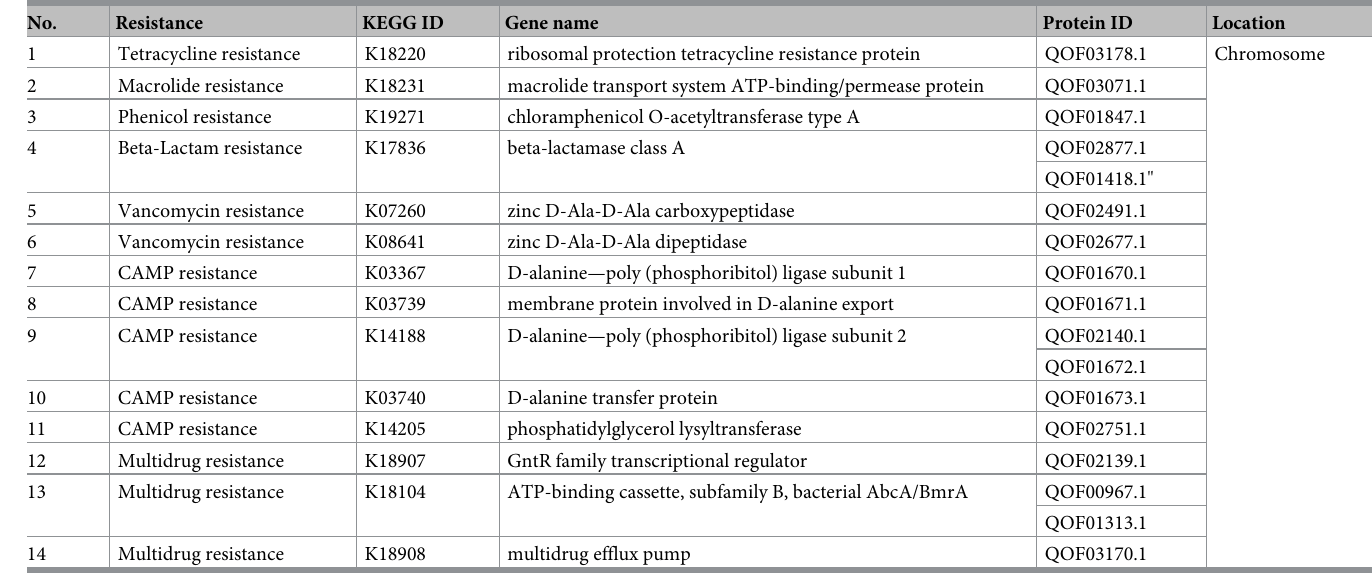
analysis, six phage regions were detected: three in the chromosome, two in plasmid 1, and one in plasmid 2 (Table 5). In addition, in mobile element analysis, nine regions were determined: five ISP2, one ISP1, and three ISLhe30, and all of them were insertion sequence (Table 6). However, antibiotic resistance genes were not present in these phage regions or mobile ele- ment sequence indicating a low possibility of transfer to other bacteria. Intrinsic antibiotic resistance is chromosomally encoded and not transferable to other bac- teria [47]. In case of vancomycin, the resistance or sensitivity is from intrinsic nature of bacte- ria such as Enterococcus , Lactobacillus , and Bifidobacterium ; their peptidoglycan cell walls have D-Ala-D-Lac termini that have low binding affinity to vancomycin [48, 49]. In contrast, acquired antibiotic resistance located on mobile genetic elements, such as plas- mids or phage regions, can be transferred from one bacterium to another, contributing to a greater and more widespread risk than intrinsic resistance [47]. When we analyzed the